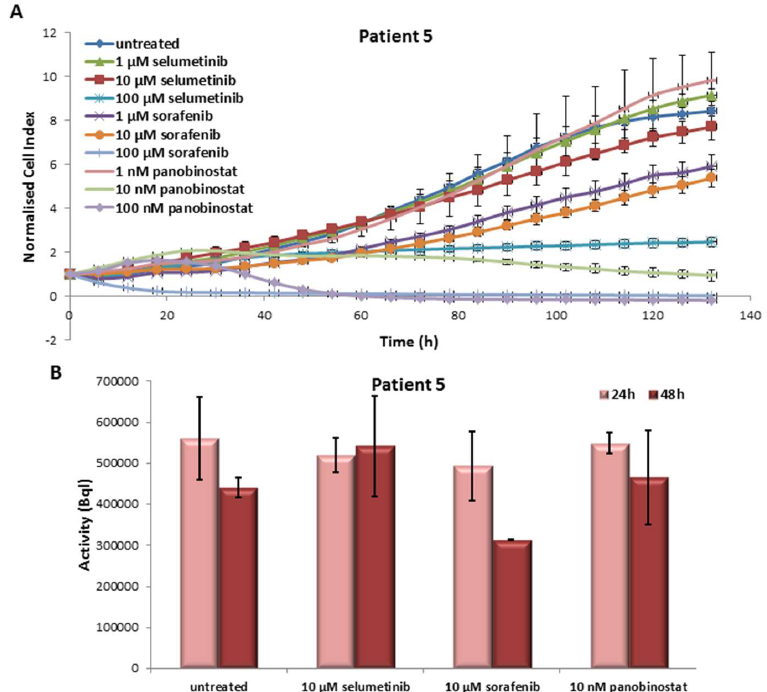
Figure 9. Effects of selumetinib, sorafenib and panobinostat on cell viability and RAI-U. Real time cell viability of PDTT cells (PDTC—Patient 5) treated with 1 to 100 µM selumetinib and sorafenib and 1 to 100 nM panobinostat ( A ). RAI-U after 24 and 48 h of treatment with 10 µM selumetinib, 10 µM sorafenib and 10 nM panobinostat ( B ). Shown are means of experiments performed in triplicates ± SD ( A )/SEM ( B ).